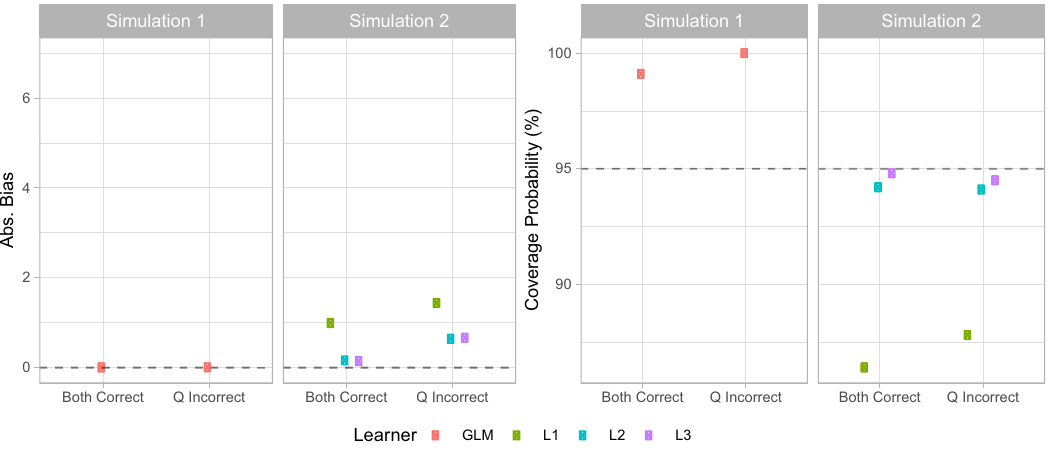
Figure 3: Absolute bias and coverage probability for both simulations – for correctly speci fi ed Q - and g - models ( Both Correct ) and misspeci fi ed Q - models ( Q Incorrect ) of